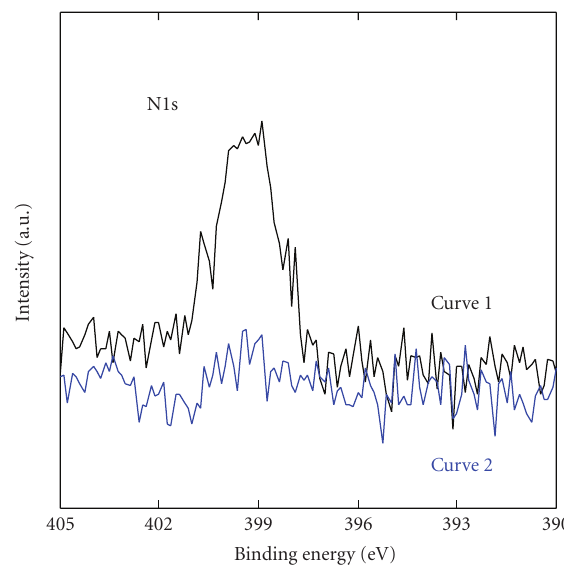
Figure 4: XPS spectra of the N-doped titania (sample B) heated to 800 ◦ C (curve 1) and 950 ◦ C (curve